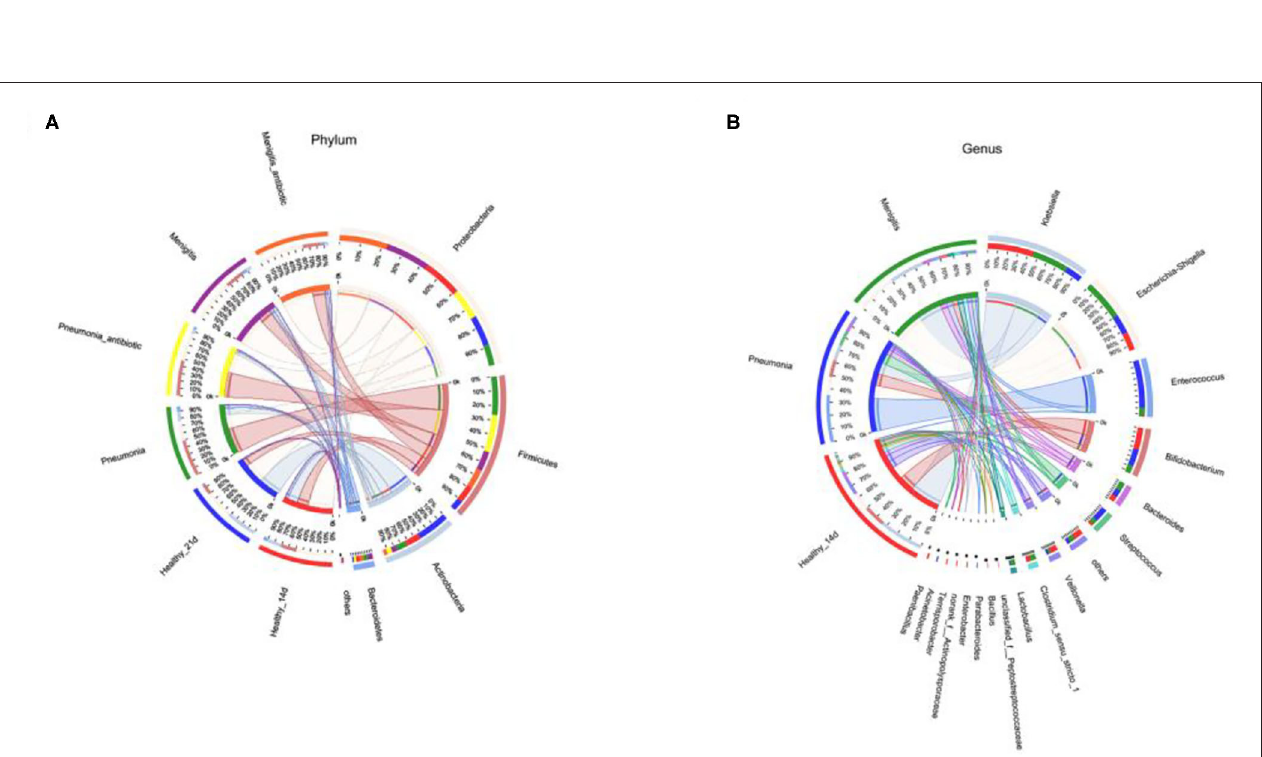
FIGURE 3 | Circos diagram of the relationship between samples at Phylum (A) and Genus (B) level.